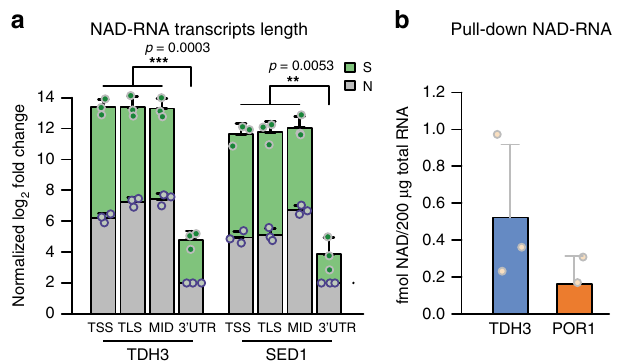
Fig. 2 Characterization of NAD-RNAs from WT yeast. a qRT-PCR of NAD- RNAs targeting different regions of the gene: the 5 ′ -end including the transcription start site (TSS), the region around the translation start site (TLS), a middle (MID) region around the fi rst in-frame ATG after the TLS, and the 3 ′ -UTR. Green bar heights represent relative transcript numbers in the sample group ( + ADPRC), whereas gray bar heights represent the transcripts numbers from the same species in the negative control group ( − ADPRC). Log 2 fold change of TLS, TSS, and MID was normalized to the 3 ′ -UTR of N (set as 2). Dots represent the measured values. Error bars represent mean + SD. Performed in biologically independent replicates, n = 3. p -values are denoted by asterisks: * p < 0.05; ** p < 0.01; *** p < 0.001 (the minimum value among TSS, TLS, MID vs. the value from the 3 ′ -UTR, Student ’ s t -test, one-sided). b Pulled-down NAD-RNA quanti fi ed by LC-MS. NAD-RNAs were estimated by measuring the NAD content, which was determined based on the signal intensity of nicotinamide riboside (NR) (fmol) from NudC-treated pulldown RNA subtracted by NR signal intensities, obtained from RNA not treated with NudC. Performed in biologically independent replicates, n = 3. Statistics parameters are as in Fig. 2a. Source data are provided as a Source Data fi Plotting the modi fi cation ratio of npy1 Δ mutant vs. WT con fi rmed that the global reduction of NAD modi fi cation is not caused by few strongly reduced species that override the effects of many weakly increased ones. The slope <1 (0.61) of this plot con fi rms that, on average, the modi fi cation in the npy1 Δ mutant is lower than in the WT (Supplementary Fig. 2l). To